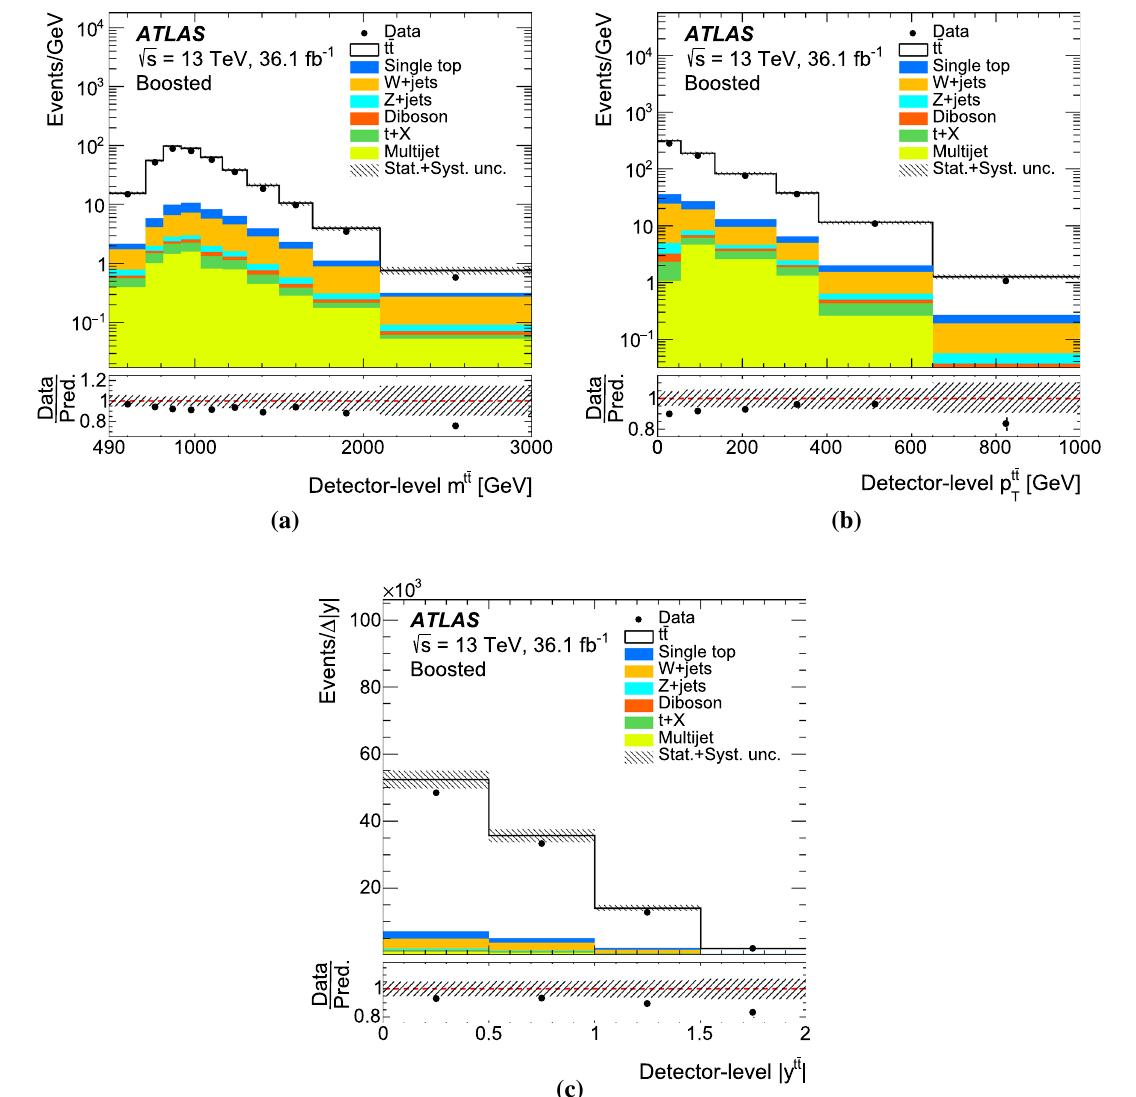
Fig. 9 Kinematic distributions in the (cid:3) + jets channel in the boosted topology at detector-level: a invariant mass, b transverse momentum and c absolute value of the rapidity of the t ¯ t system. Data distribu- tions are compared with predictions, using Powheg + Pythia8 as the t ¯ t signal model. The hatched area represents the combined statistical and